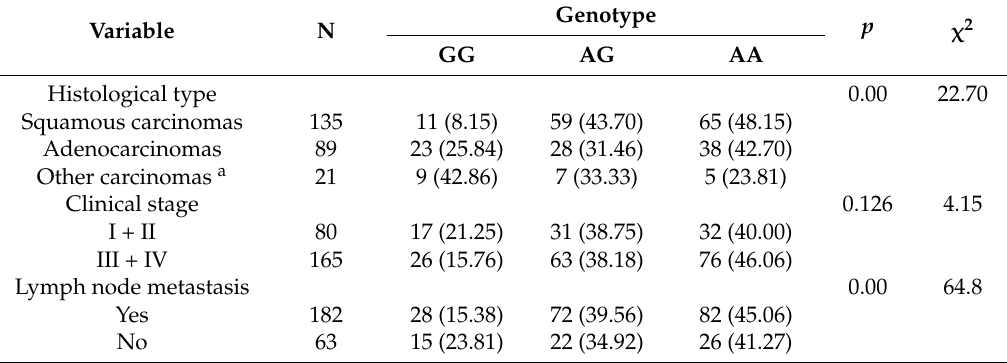
Table 7. Correlation between MMP-13 and clinical pathology parameters in NSCLC.